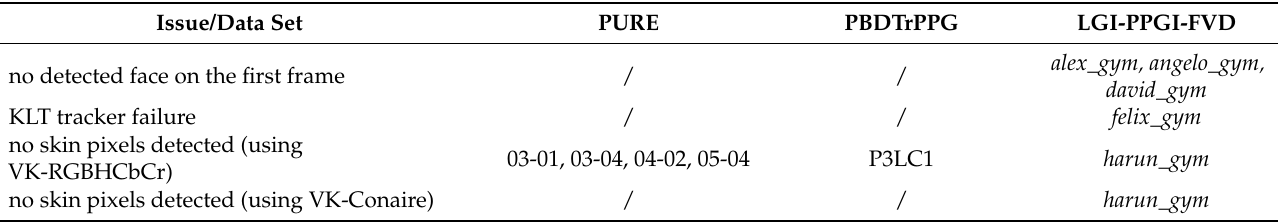
Table 1. The identified issues during ROI localization step using the studied approaches and the IDs of the recordings in which the issues occurred. VK-Conaire: Viola-Jones combined with skin detector based on the maximization ofmutual information and Kanade–Lucas–Tomasi tracker; VK-RGBHCbCr: Viola-Jones combined with RGB-H–CbCr skin-color segmentation and Kanade–Lucas–Tomasi tracker; KLT: